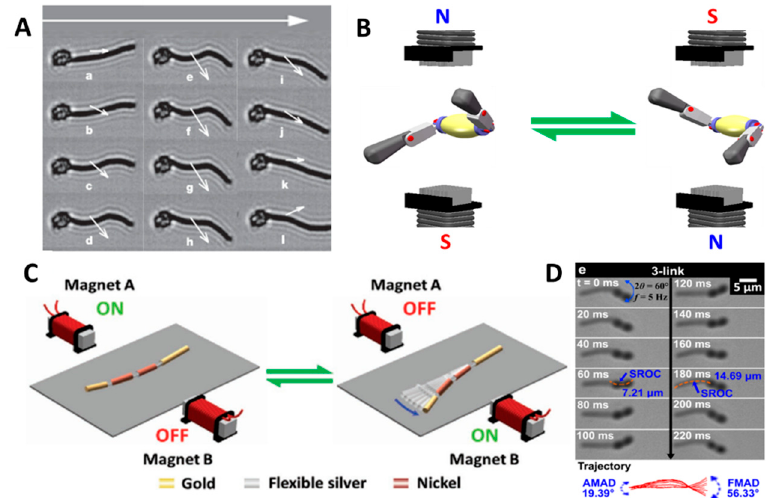
Figure 6. ( A ) Beating pattern of the motion of a magnetic flexible filament attached to a red blood cell. Adapted with permission from Reference [106] copyright Nature 2005. ( B ) Schematic showing the magnetic setup for propulsion along with the vibrating magnetic field. Adapted with permission from Reference [83], copyright Nano Letter 2015. ( C ) Magnetic propulsion of an artificial nanofish using a planar oscillating magnetic field. Adapted with permission from Reference [84], copyright Small 2016. ( D ) Image sequences of 3-link swimmers’ wagging motion. Adapted with permission from Reference [104], copyright Nano Letter